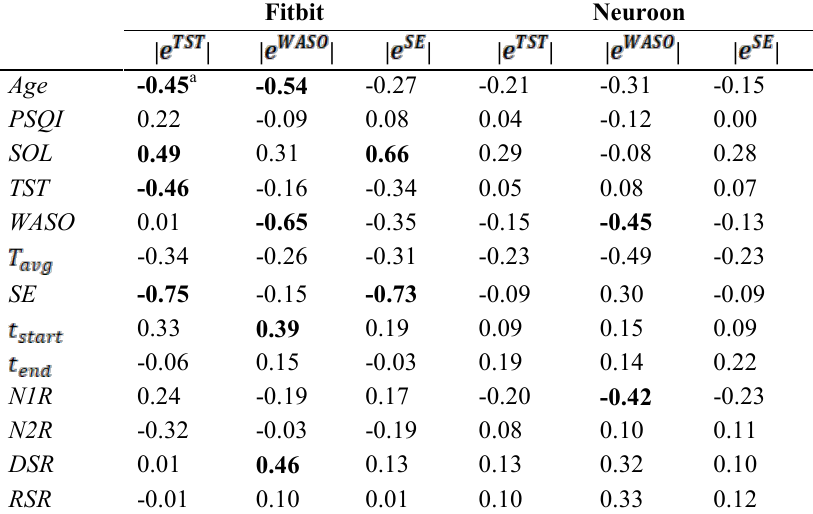
Table 7. Pearson correlation coefficients between user-specific factors and absolute percent